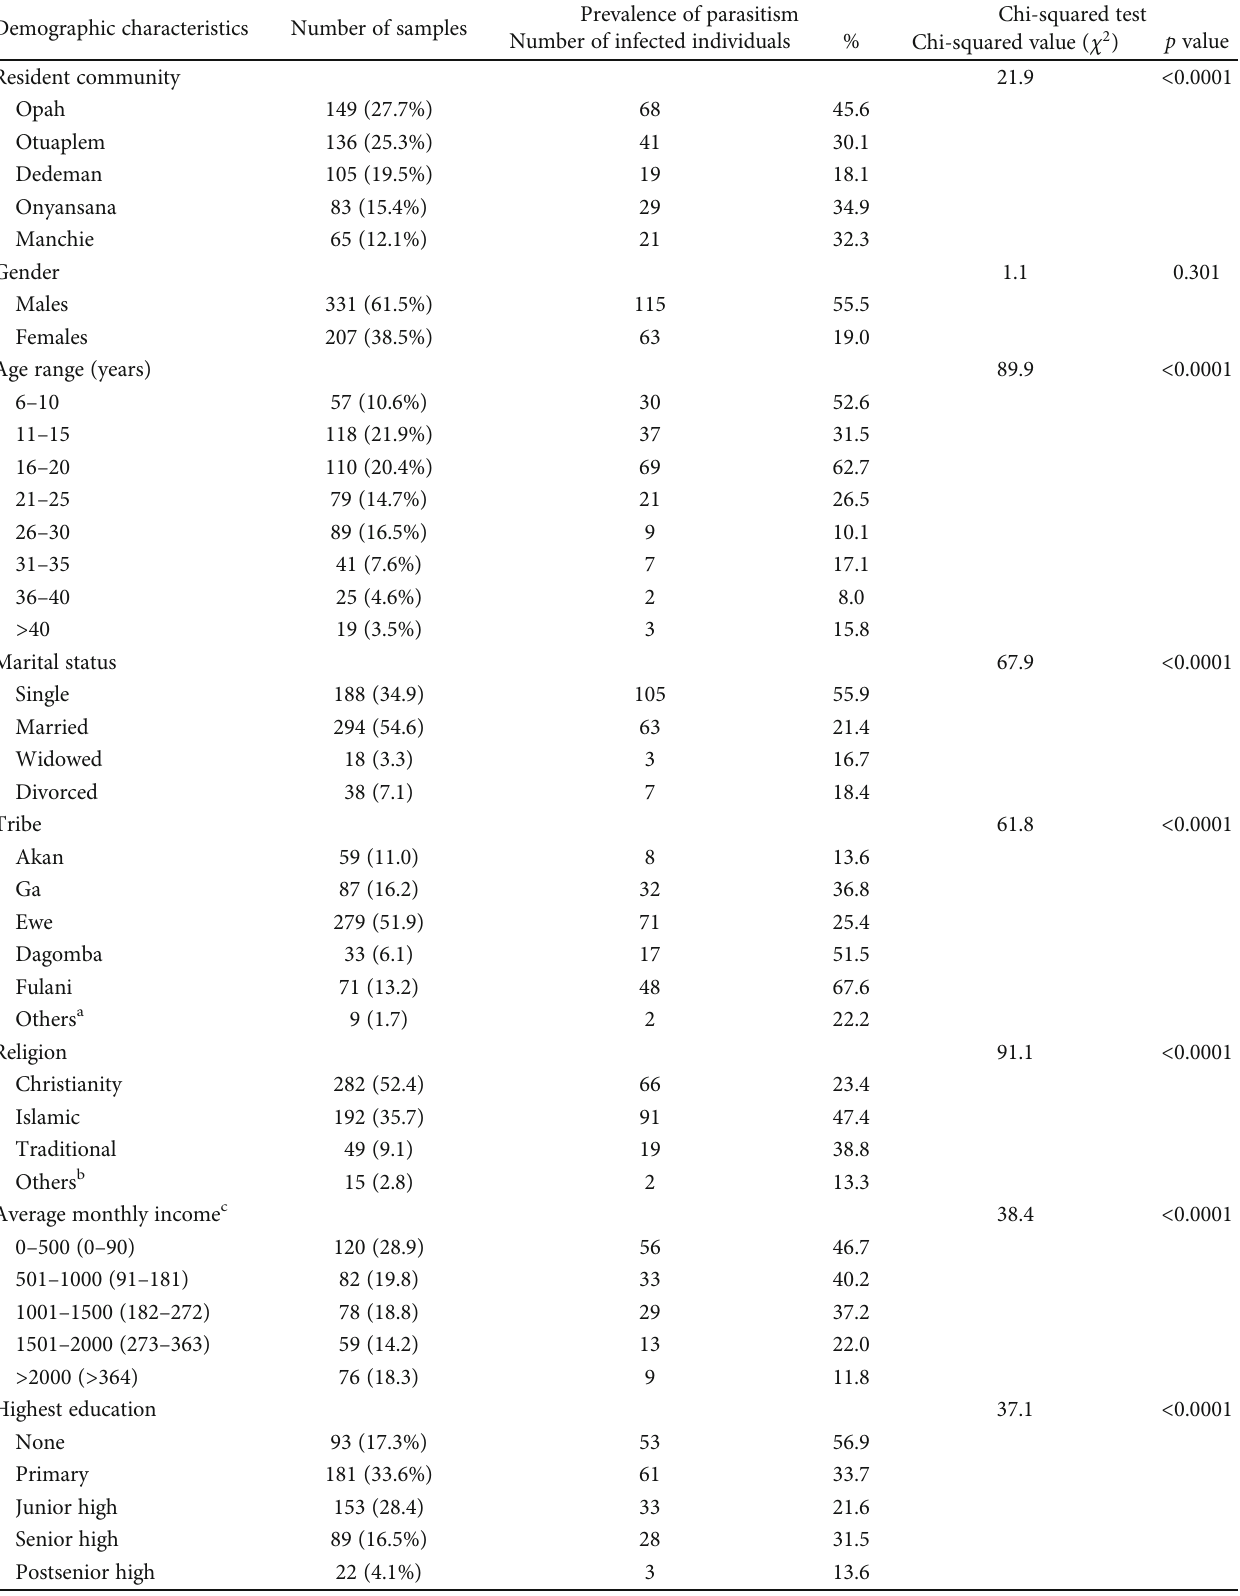
Table 1: Association of prevalence of enteroparasitism with sociodemographic